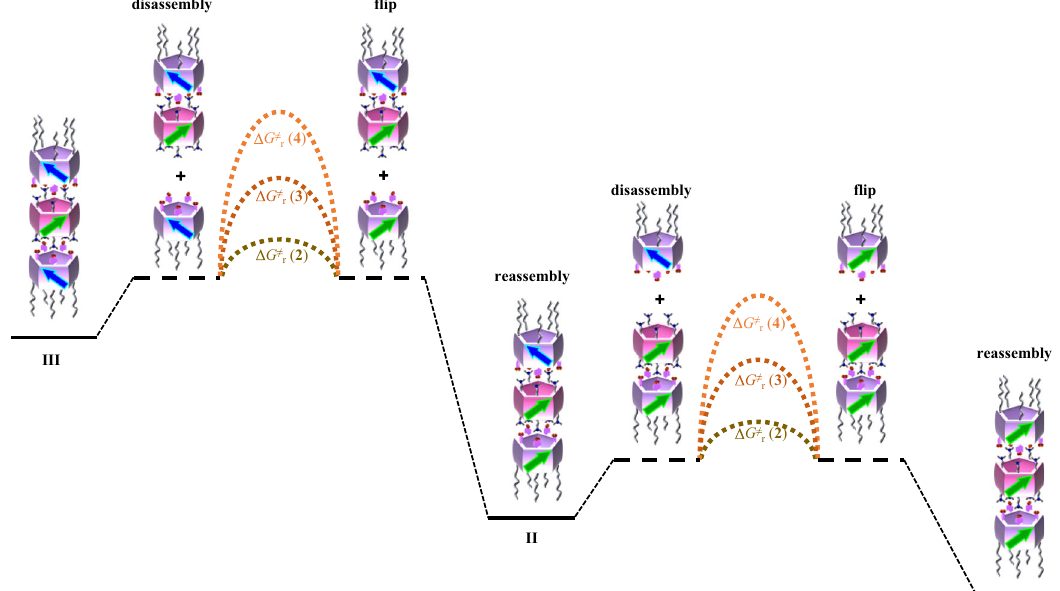
Fig. 5 | Schematic representation of the effect of alkyl chain length on the kineticsofchiralitytransfer. Δ G ‡ r ( 2 ), Δ G ‡ r ( 3 ),and Δ G ‡ r ( 4 )representtherotation barrierofacidicpillar[5]arene 2 , 3 ,and 4 ,respectively.Theresultingassemblies III (or II )from 2 , 3 , 4 requirealmostthesameenergytodissociateoneacidicpillar[5]